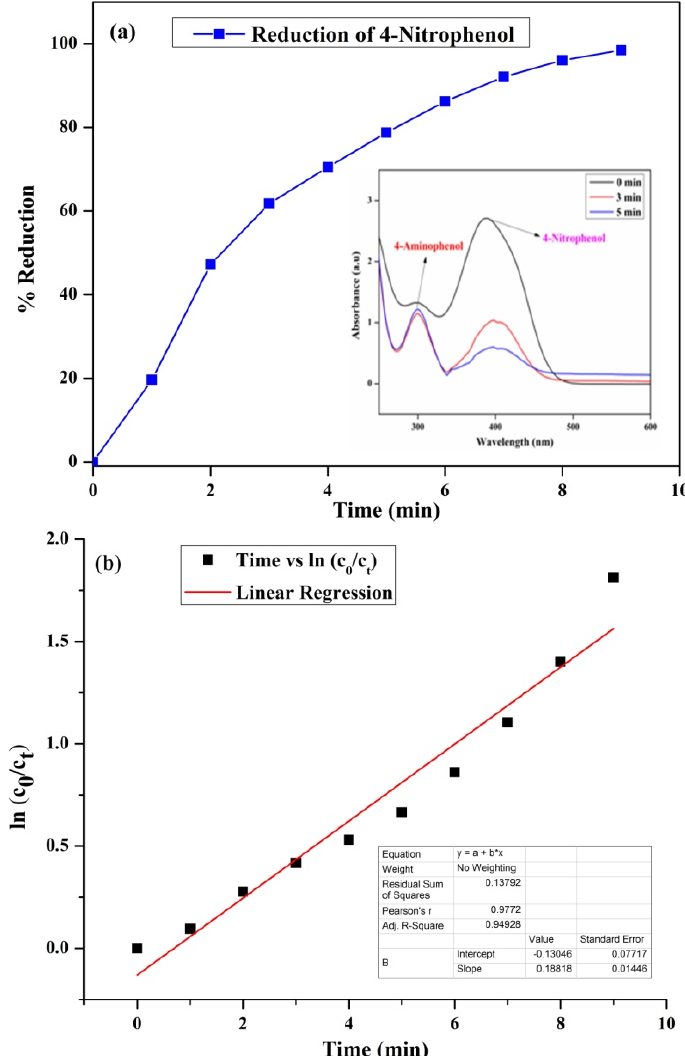
Figure 9. ( a ) plot of time vs. % reduction and ( b ) time vs. ln (c 0 /c t ) and linear regression.